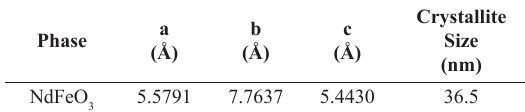
Fig. 6 Phase quantification using Rietveld